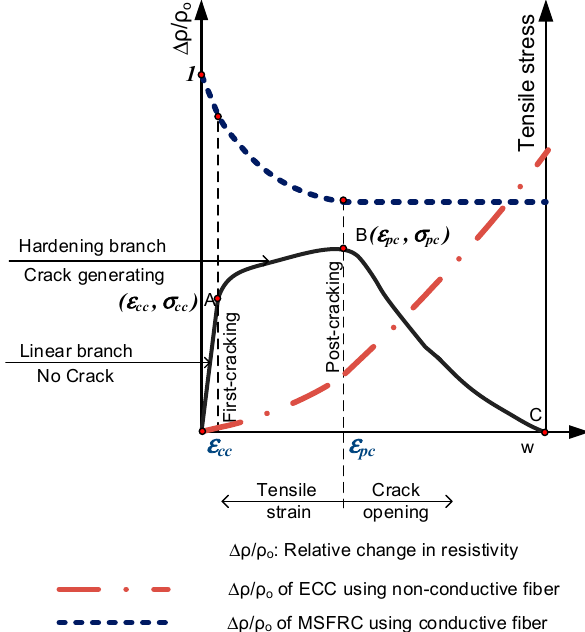
Figure 14. Representative electro-tensile behavior of strain-hardening composites.